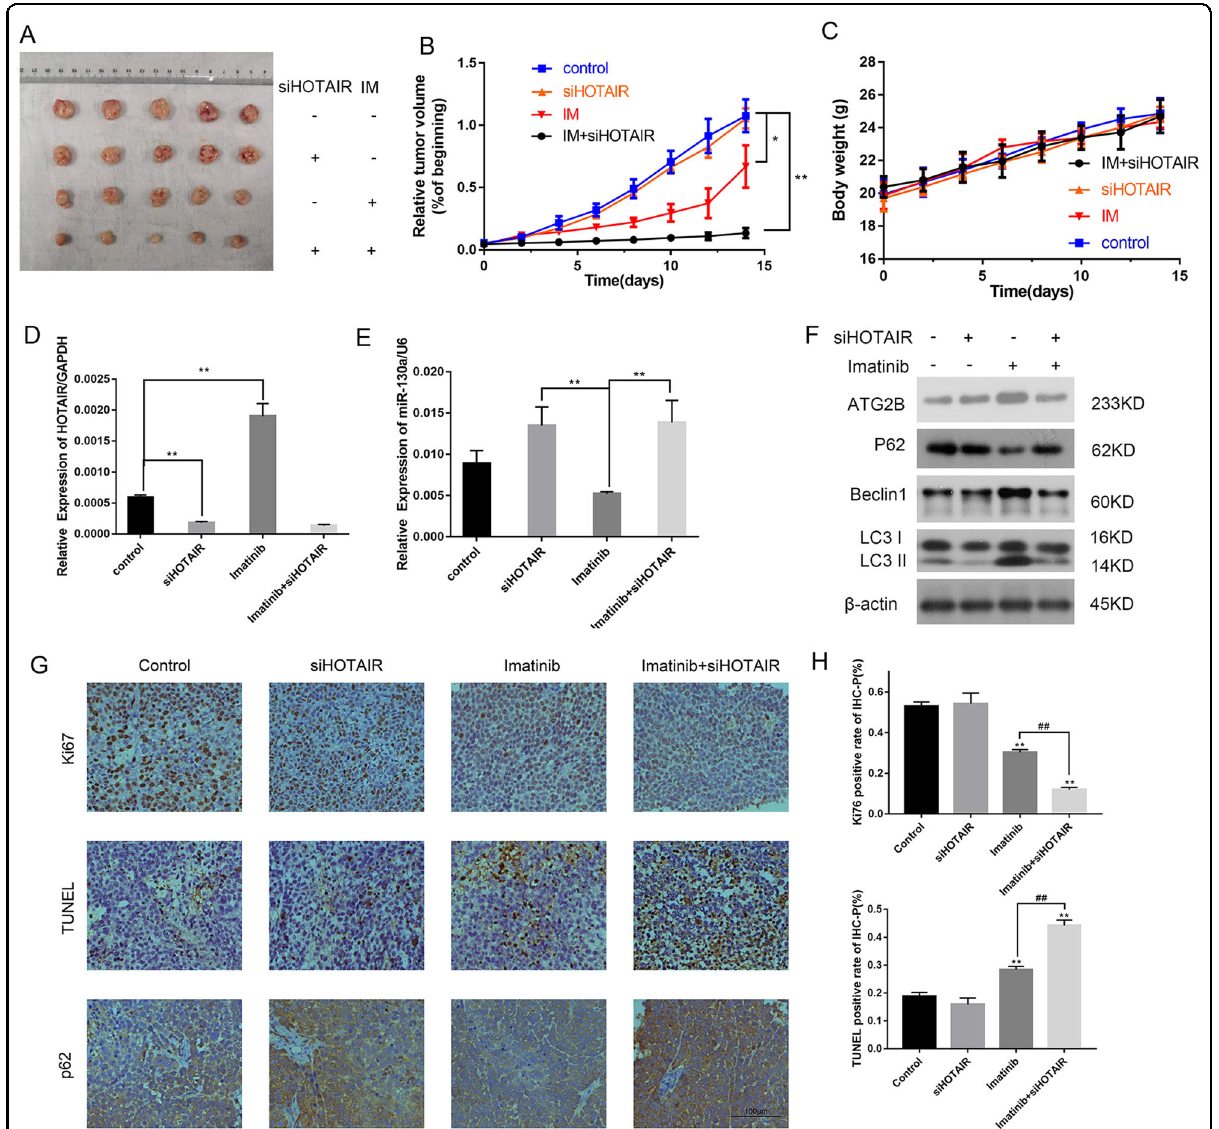
Fig. 7 The downregulation of HOTAIR increased the sensitivity of GIST cells to imatinib in vivo. A Size of the excised tumors after 14 days of treatment with or without imatinib in the presence or absence of siHOTAIR. B Average percent change in tumor volume relative to the beginning for each treatment. * P < 0.05; ** P < 0.01 vs. control. C Changes in body weight for each treatment. D , E The relative expression levels of HOTAIR and miR- 130a were analyzed in the four groups using qRT-PCR. ** P < 0.01 vs. control or imatinib. F The levels of autophagy-related proteins ( ATG2B , Beclin1, p62, and LC3) were detected using western blotting. G Representative pictures of Ki-67 staining, TUNEL assays, and immunohistochemistry for p62. H The positive rates of Ki-67 staining and TUNEL assays. ** P < 0.01 vs. control. ## P < 0.01 vs.